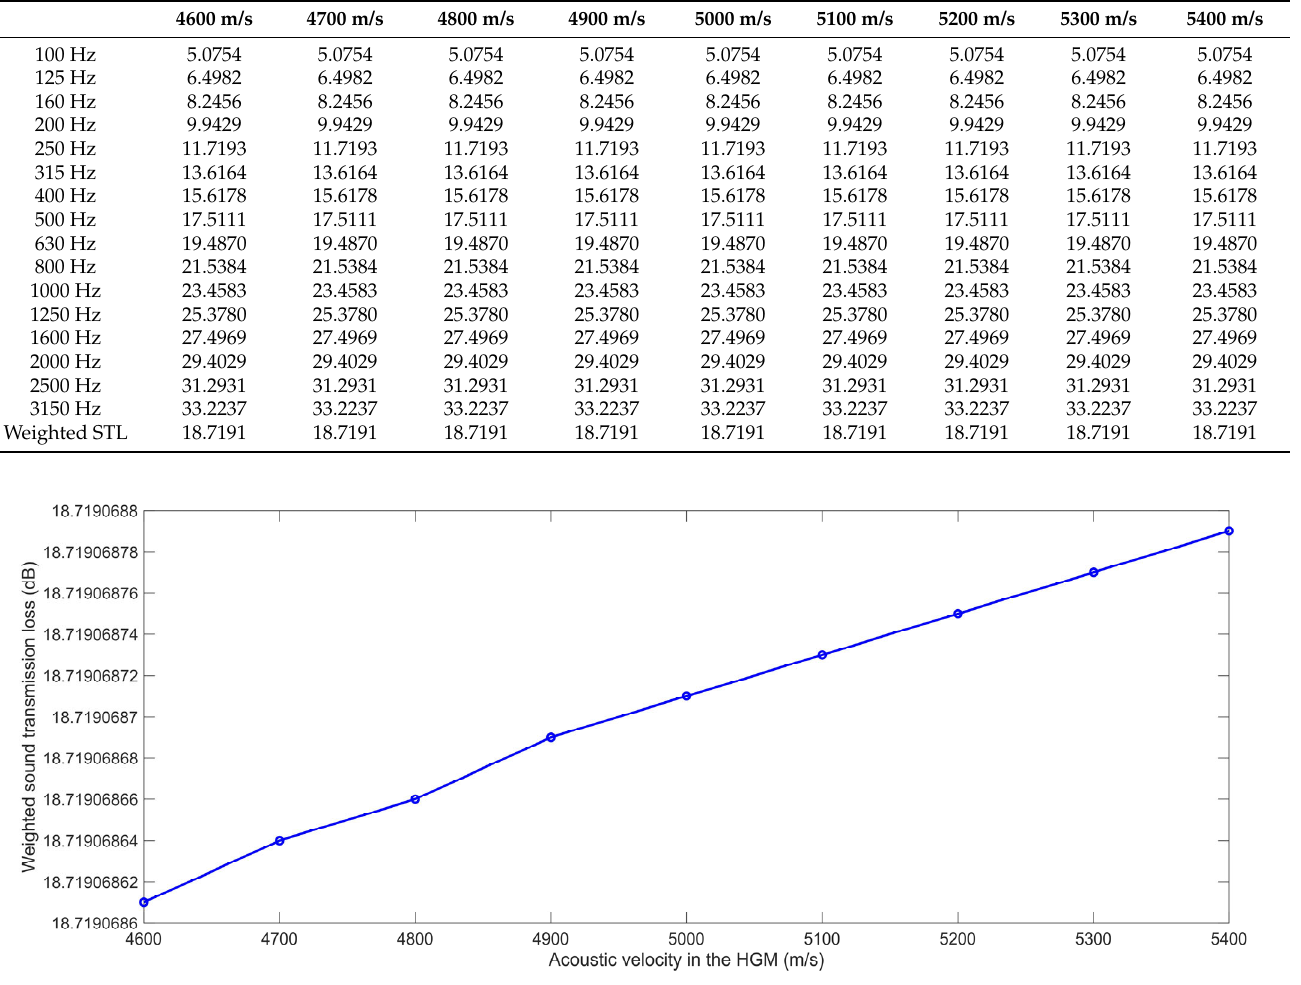
Figure 17. The weighted STL of the composite rubber reinforced with HGM for the various acoustic velocity in the HGM.